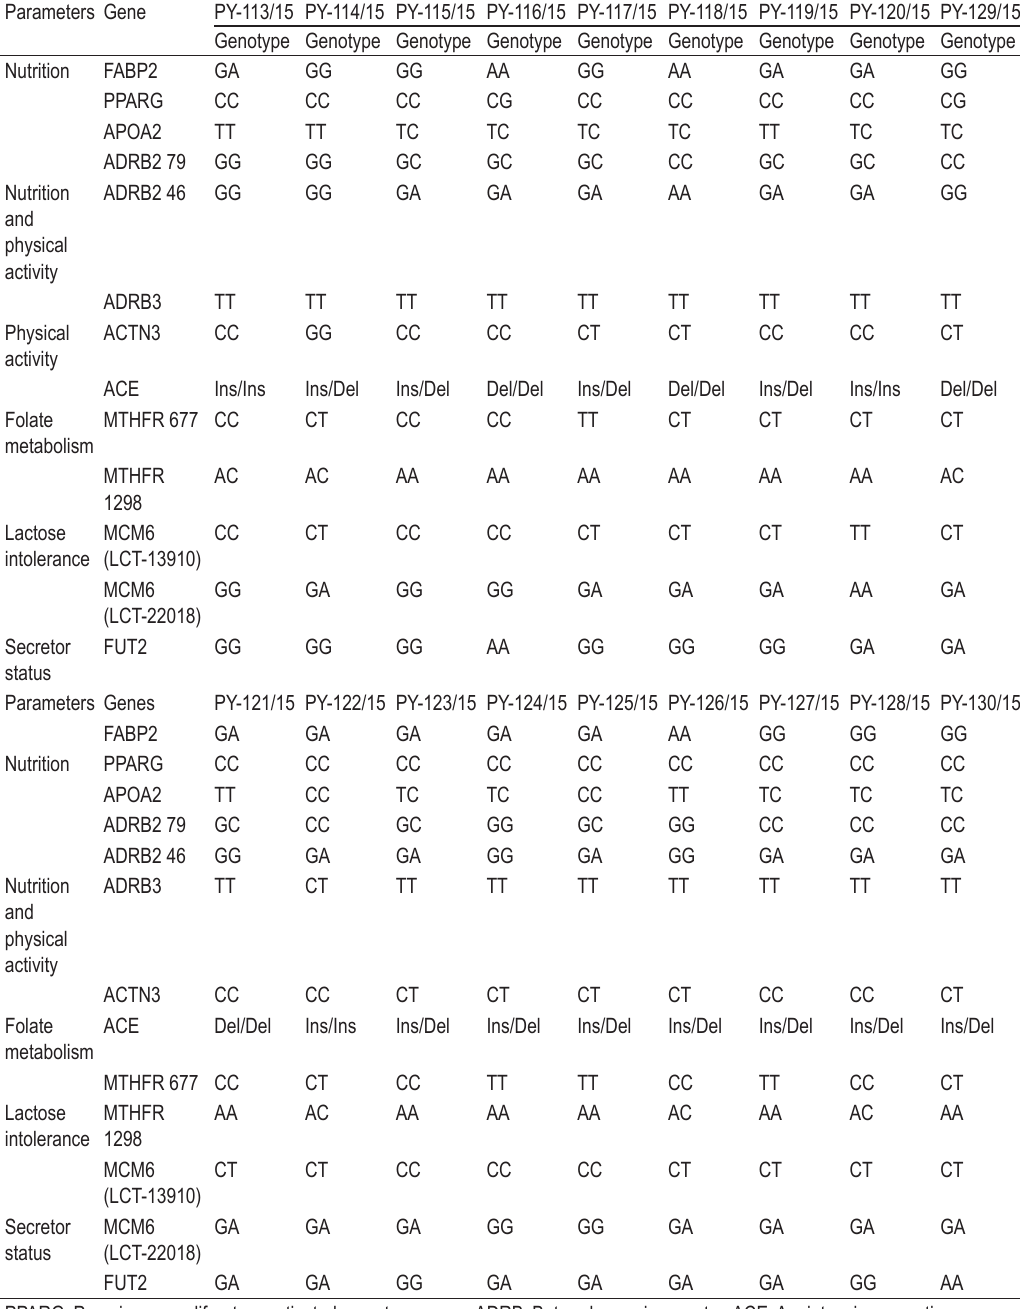
TABLE 2. Volunteers’ personal